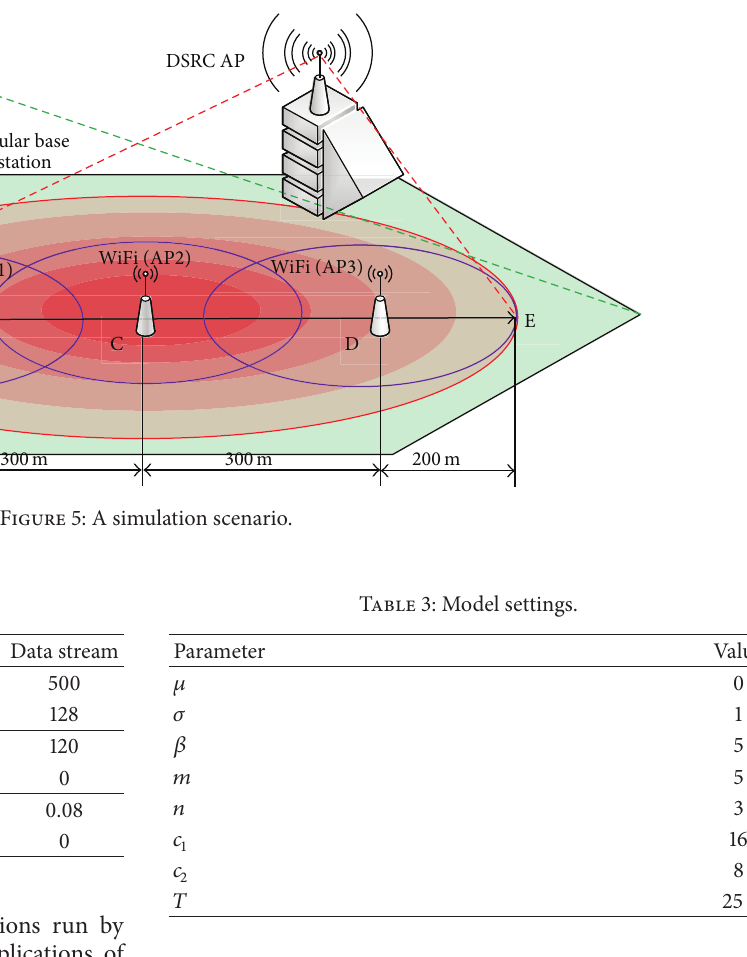
Table 4: Settings on the